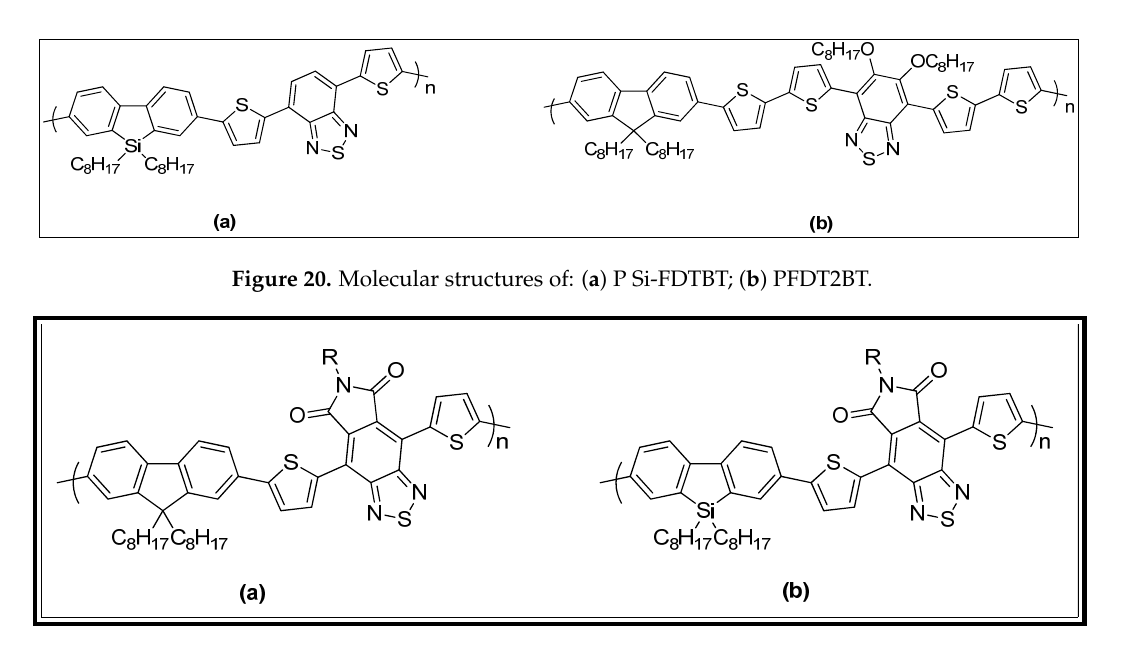
Figure 22. Molecular structure of PCDTBT.